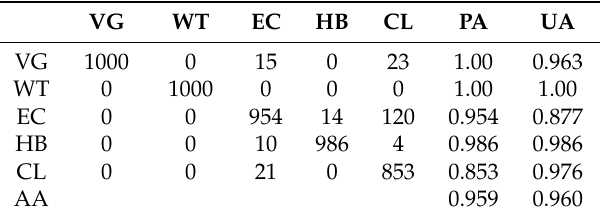
Table 17. Confusion matrix of the SAE in the second area.